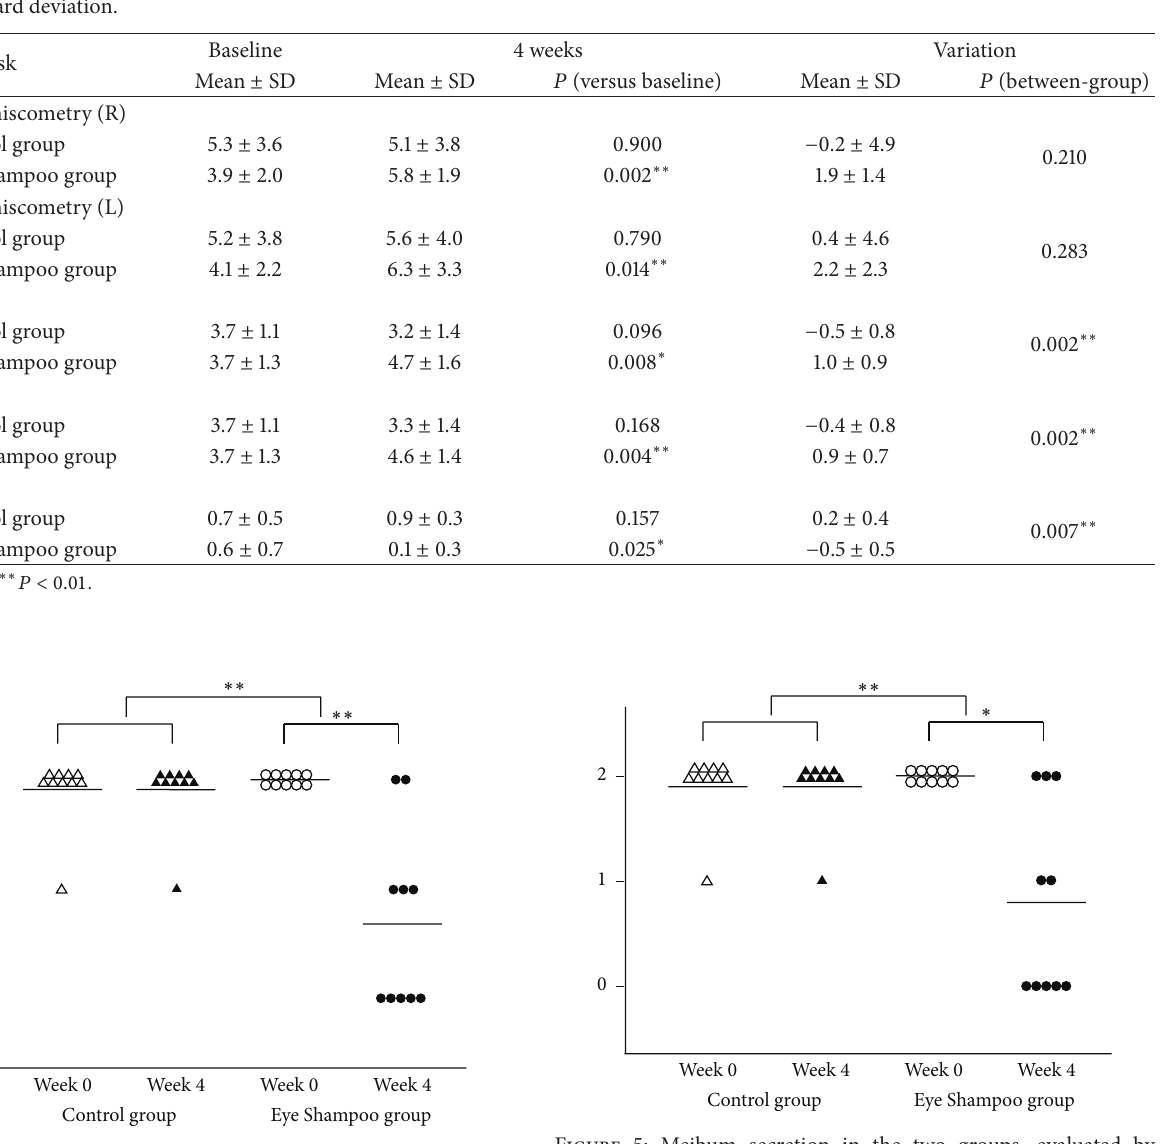
Figure 4: Meibomian gland orifice obstruction in the two groups. 0, absent; 1, slight; 2, prominent.